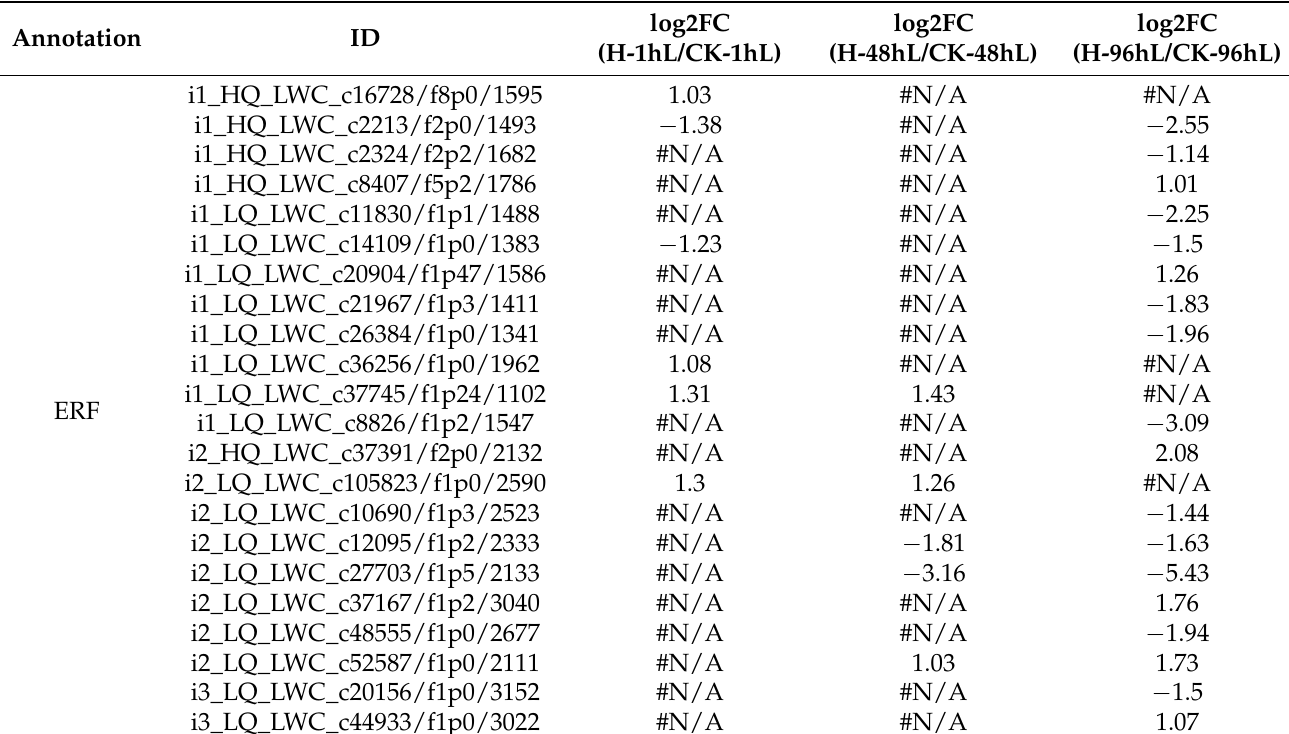
Figure 3. TF analysis of pearl millet under heat stress for1, 48, and 96 h. ( a ) The TFs Venn diagram of pearl millet showing the DEG overlaps after heat stress for 1, 48, and 96 h, including the Venn diagrams of all differentially expressed TFs, the up-regulated TFs Venn diagram and the down-regulated TFs Venn diagram. ( b ) The percentage of differentially expressed HSFs, bZIPs, ERFs, ARFs, NACs, wrkys and bhlhs (differential expression/total number). Blue represents the differential expression percentage of TF in pearl millet after 1h of heat stress, orange represents the differential expression percentage of TF in pearl millet after 48 h of heat stress, and gray represents the percentage of differential expression of TF in pearl millet after 96 h of heat stress. Table 1. Expression of stress-related TF in pearl millet leaves under heat stress.